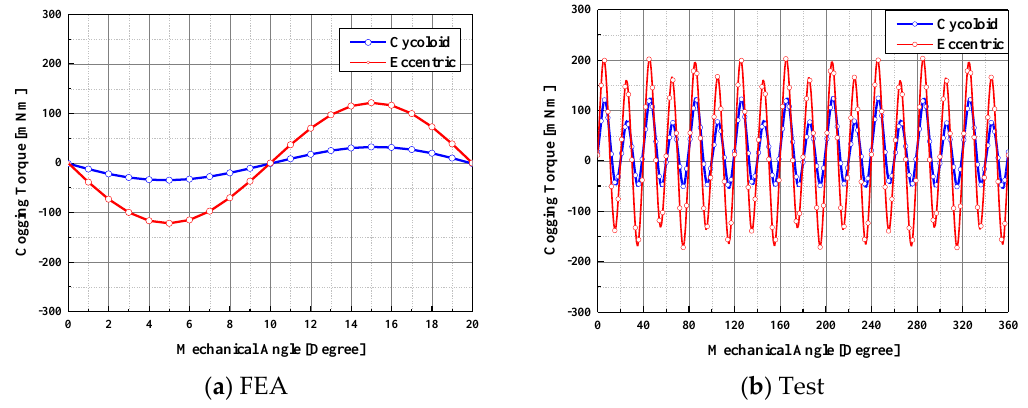
Figure 15. Cogging torque FEA and test results: ( a ) FEA; ( b ) test.